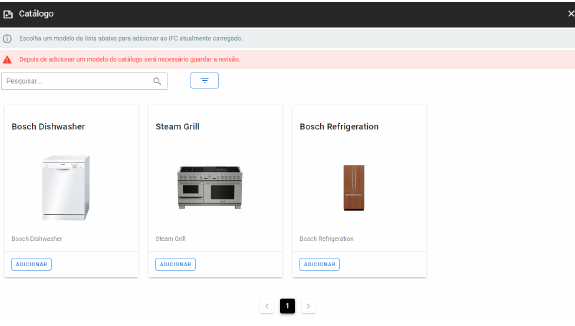
Figure 2. IFC revisions available to load in the 3D scene.